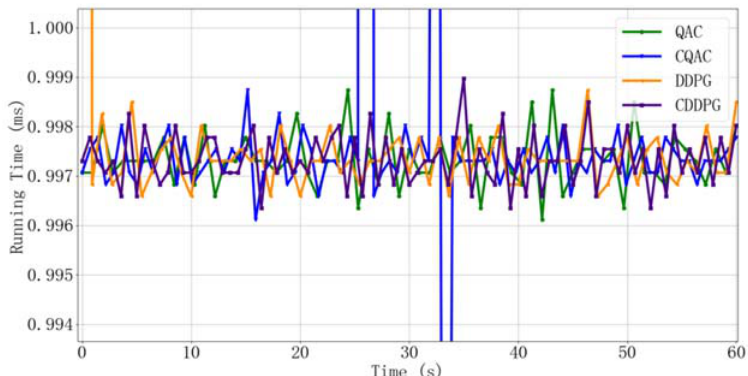
Figure 7. Training steps of four algorithms.